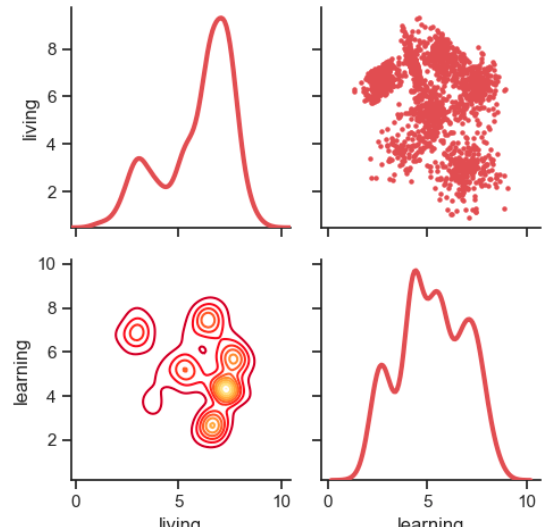
Figure 7. The scatter plot matrix of S4.